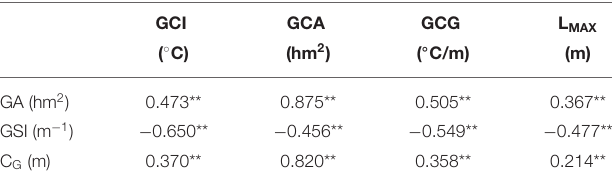
TABLE 2 | Correlation analyses between cooling indicators and spatial features of green